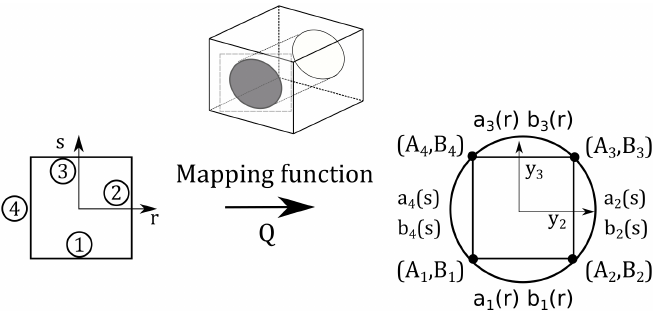
Figure 2. Mapping of the fibre section of the RUC by means of the blending function method. Reprinted from Reference [42], with permission from Elsevier.